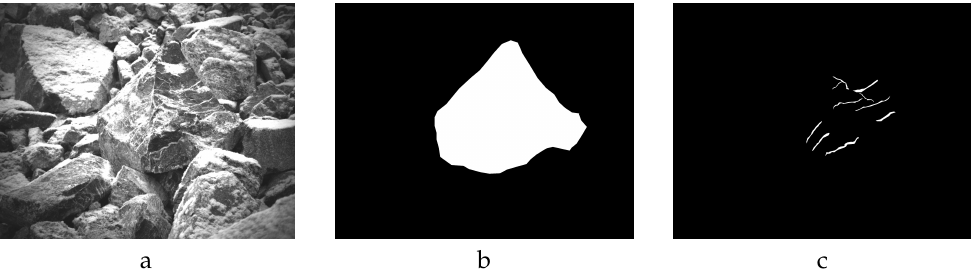
Figure 7. The typical image ( a ), its labelled mask of alone rock chunks boundaries ( b ), and veins ( c ) for the dataset № 4.